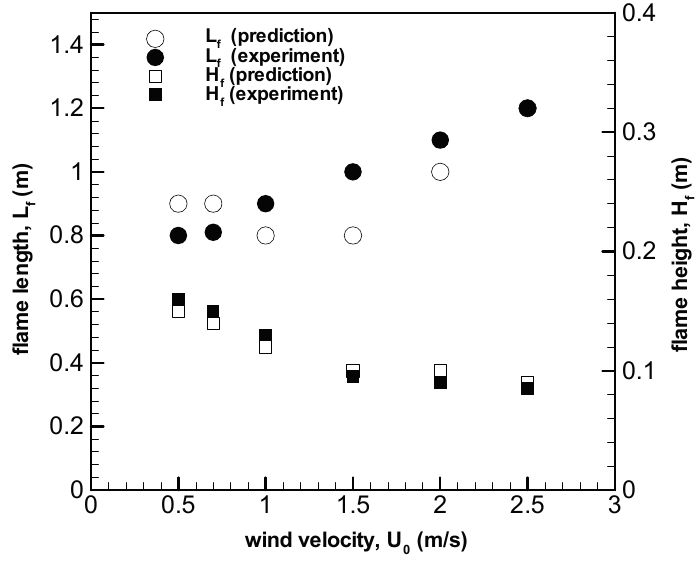
Figure 9. Comparison between the predicted and measured flame height/length as a function of the wind